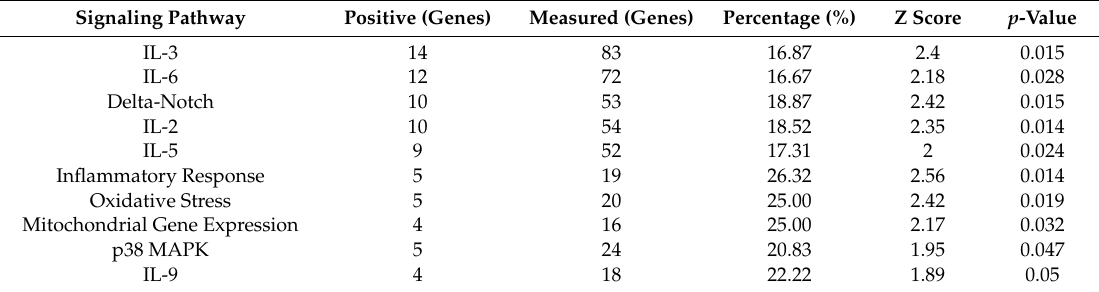
Table 1. Renin angiotensin system (RAS) overexpression a ff ects inflammatory and cell-stress signaling pathways. Top 10 significantly di ff erent signaling pathways in Agt Tg compared to Wt mice white adipose tissue (WAT). Percentage represents the number of interested genes significantly regulated (positive genes) out of total genes included in the pathway (measured